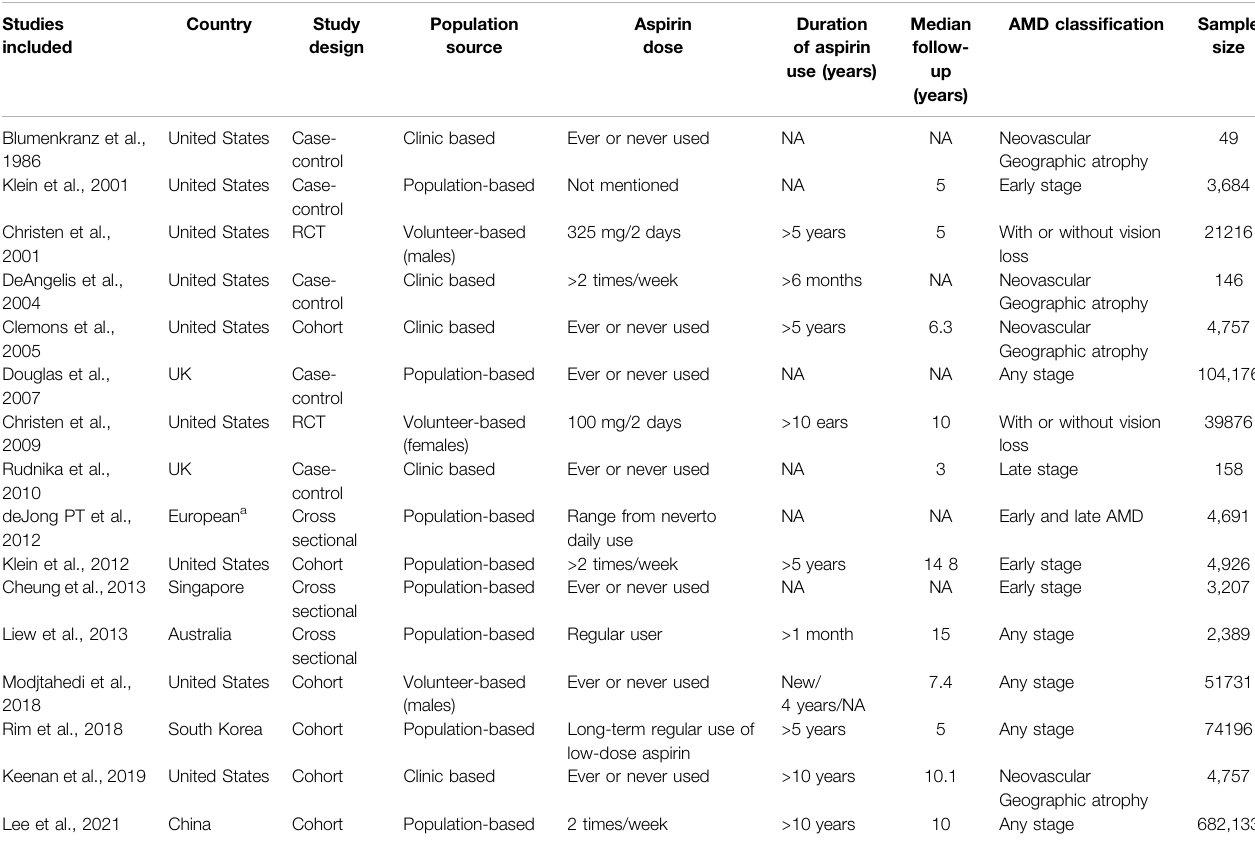
TABLE 1 | Characteristics of study